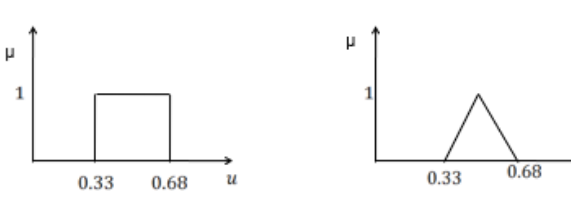
Figure 2. Representation of Type − 2 fuzzy sets with secondary membership function.